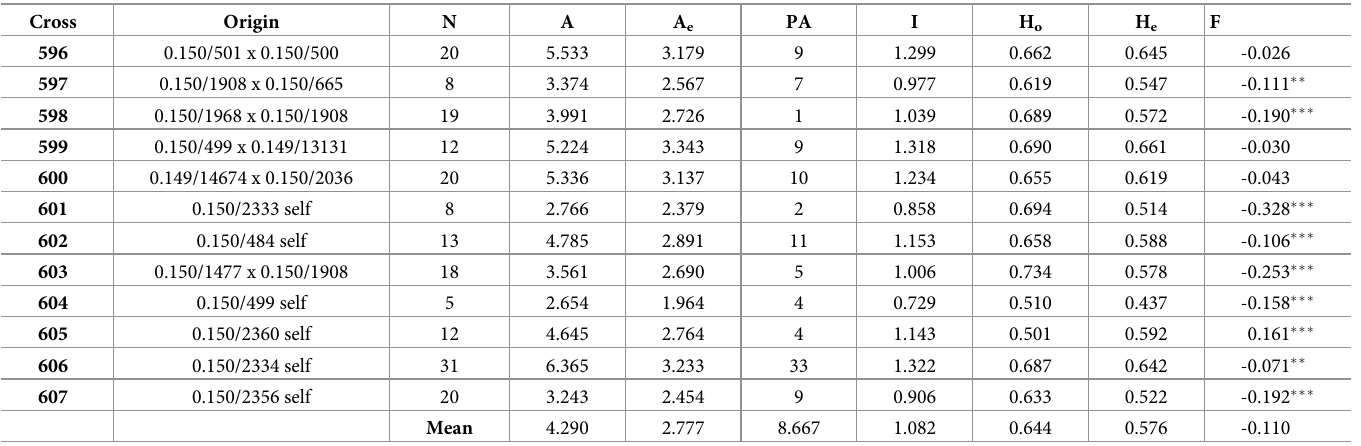
The genetic distance calculated among the Nigerian-based populations revealed close genetic relationship (mean = 0.466). The largest genetic distance was observed between pop. 601 and 597 (0.698) whereas the closest genetic relationship was between pop. 598 and 603 (0.242) (Table 4). Both analysis of molecular variance (AMOVA) and pairwise F formed to investigate the genetic variations among the populations. High genetic differentia- tion was observed among pop. 604 with pop. 597, 598, 599, 600, 601, 603 and 607 ( F 0.153–0.202) as well as among pop. 607 with pop. 597 and 601 ( F tively) (Table 4). Population 597 was also genetically distant from pop. 601 ( F the remaining populations have moderate genetic differentiation ( F average genetic differentiation among populations was 0.120 and the overall gene flow value ( Nm ) was estimated at 1.117, indicating certain level of alleles migration among populations. AMOVA analysis further disclosed that 71% of molecular variance observed was due to the genetic difference within population, whereas 29% genetic variation was partitioned among populations. A total of eight genetic clusters were discerned from UPGMA clustering for the 186 Nige- rian palms (Fig 1). Mixture of palms from various populations were segregated out to form cluster I (596/14, 596/32, 599/9, 600/36, 605/9, 605/11, 605/16, 606/4 and 606/56). Clusters II and III consisted of majority of palms from pop. 599 and 597, respectively. Palms from Table 3. Genetic diversity among the Nigerian-based populations. Cross